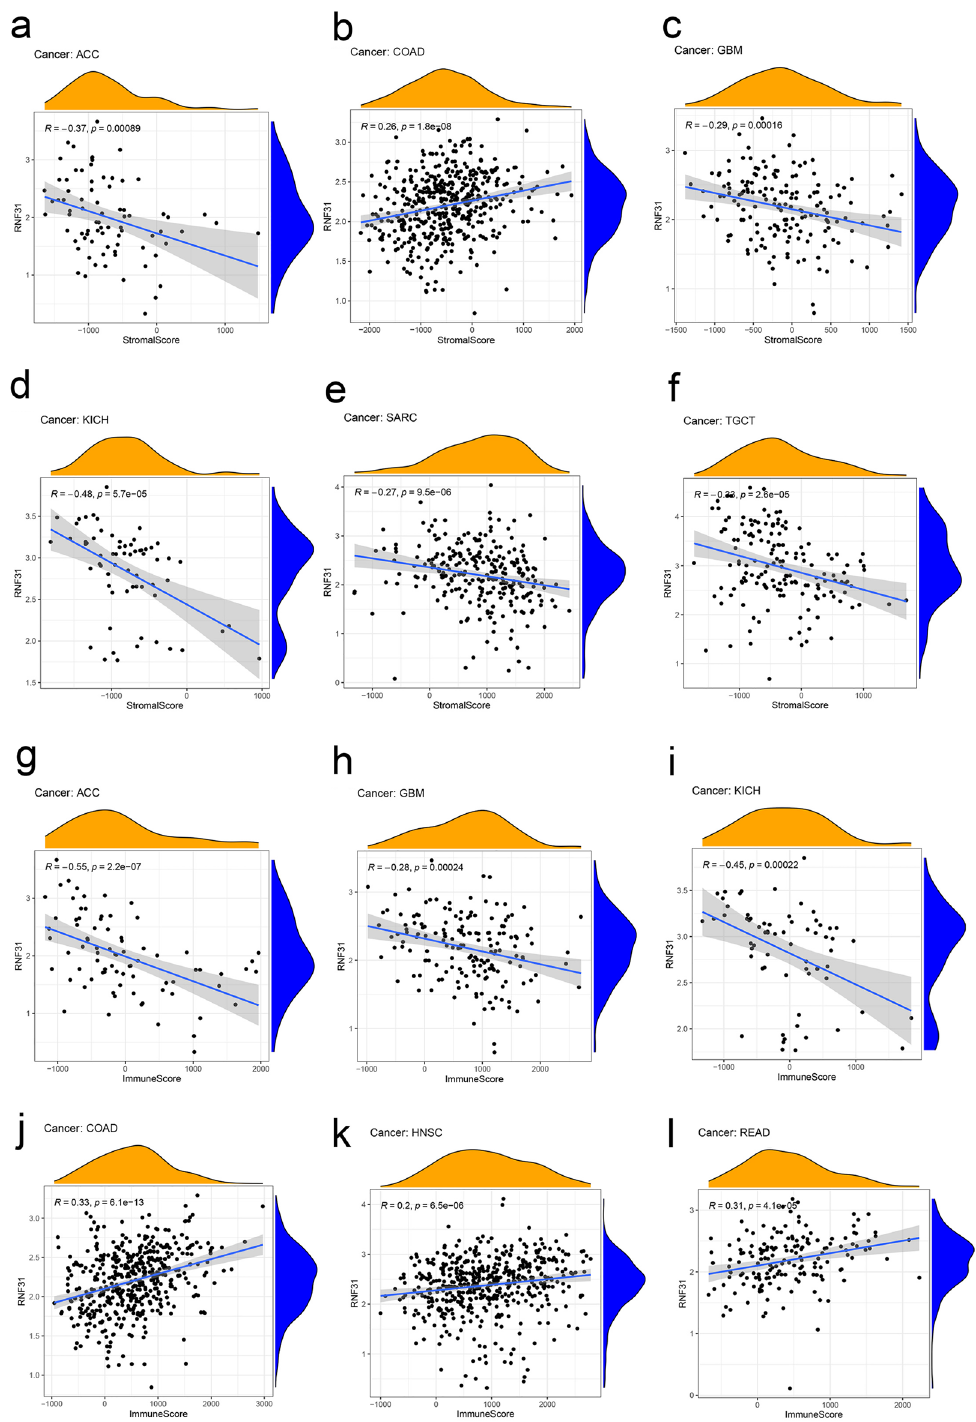
Figure 3. Correlation coefficients between RNF31 expression and the tumor microenvironment factors. ( a – f ) Correlation between RNF31 and stromal scores in ACC, COAD, GBM, KICH, SARC, and TGCT. ( g – l ) Correlation between RNF31 and immune scores in ACC, GBM, KICH, COAD, HNSC, and